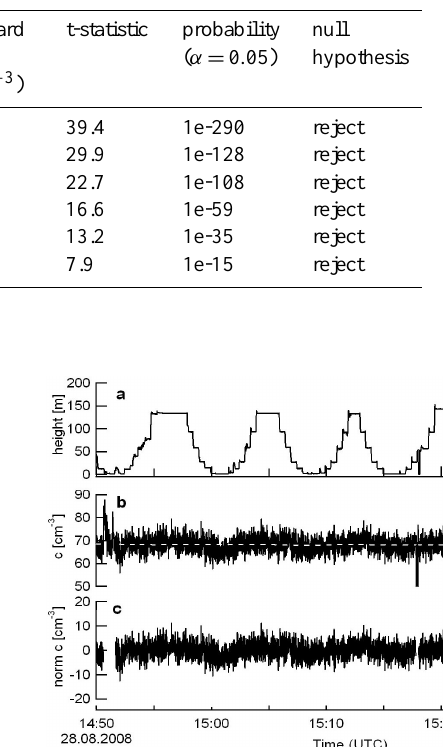
Table 1. T-test results for adjacent means of the temperature profile on 31 August.